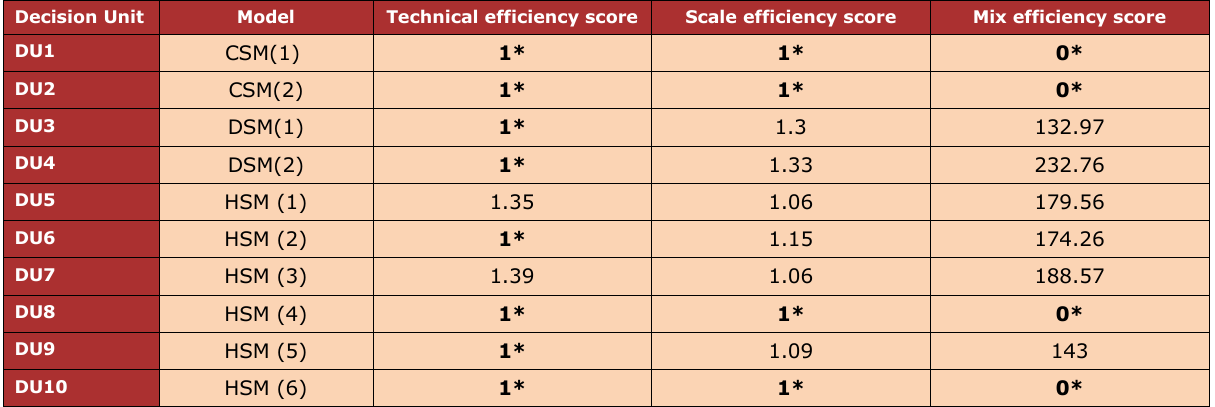
Table 12. Inefficiency terms for the setting with medium